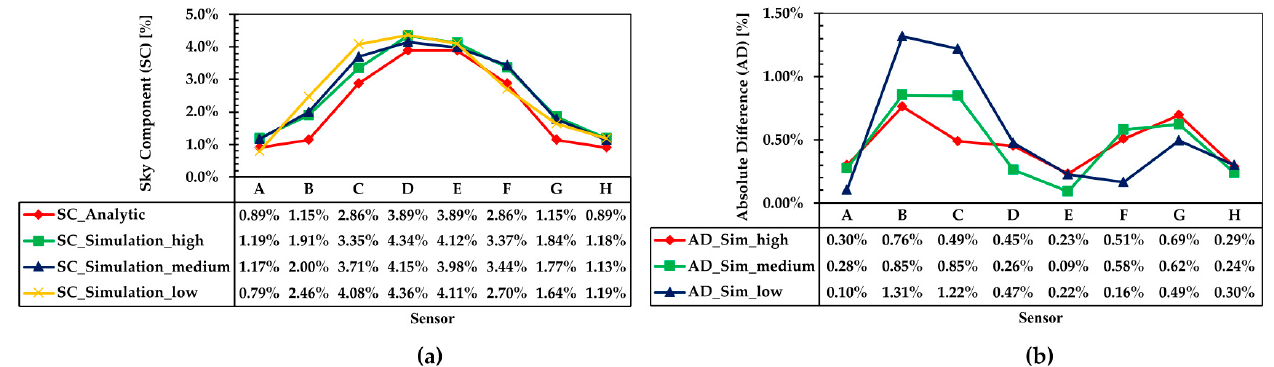
Figure 5. ( a ) Analytical and simulation SC values and ( b ) absolute difference at all calculation points inside the modified model of the CIE test case 5.13 (Figure 1b).